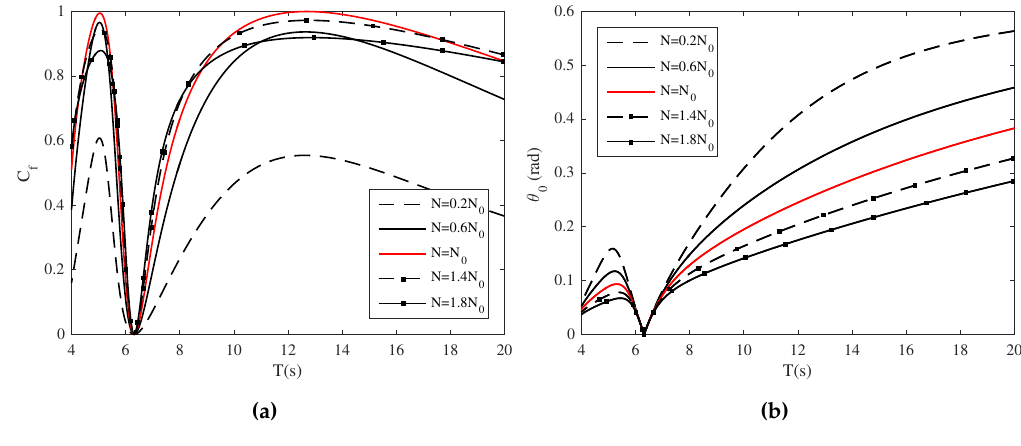
Figure 11. ( a ) Variation of capture factor ( C f ) and ( b ) Amplitude of angle of oscillations ( θ 0 ), with wave period ( T ), for different PTO system damping ( N